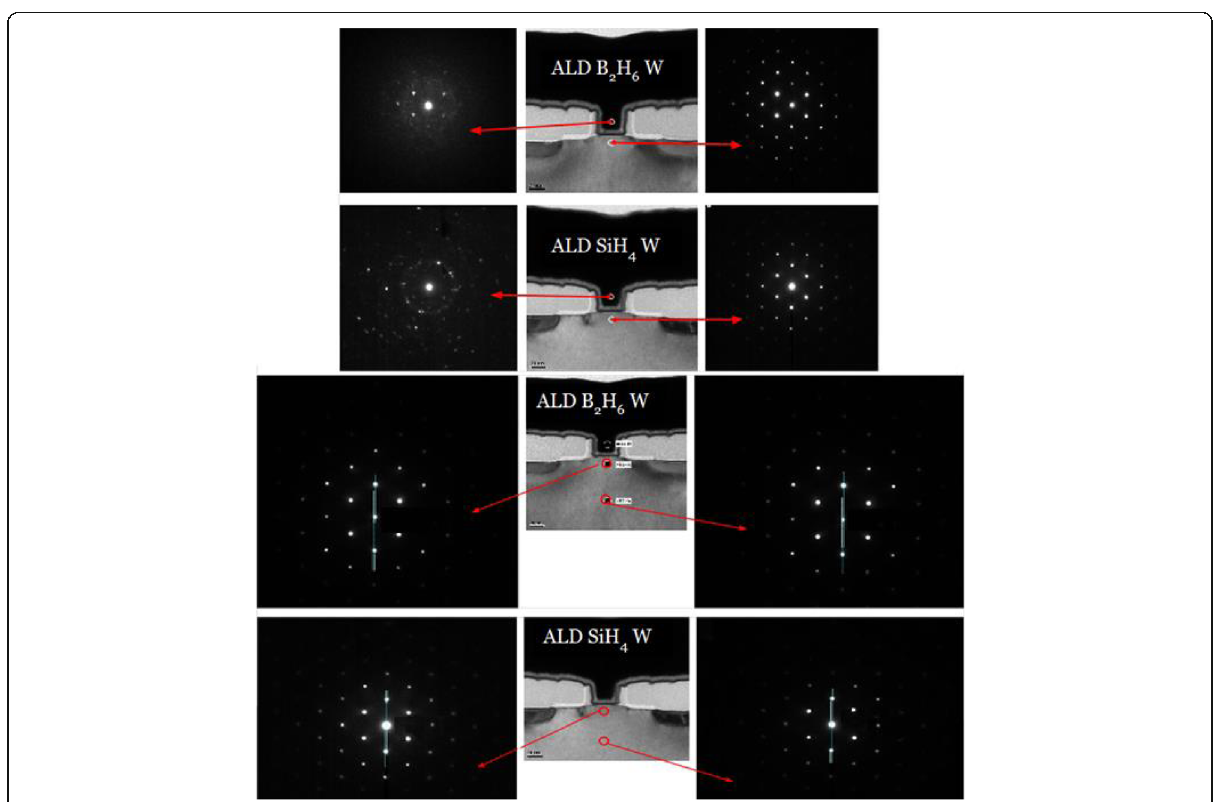
Fig. 3 NBD images from metal gate, channel, and the reference regions of the transistors